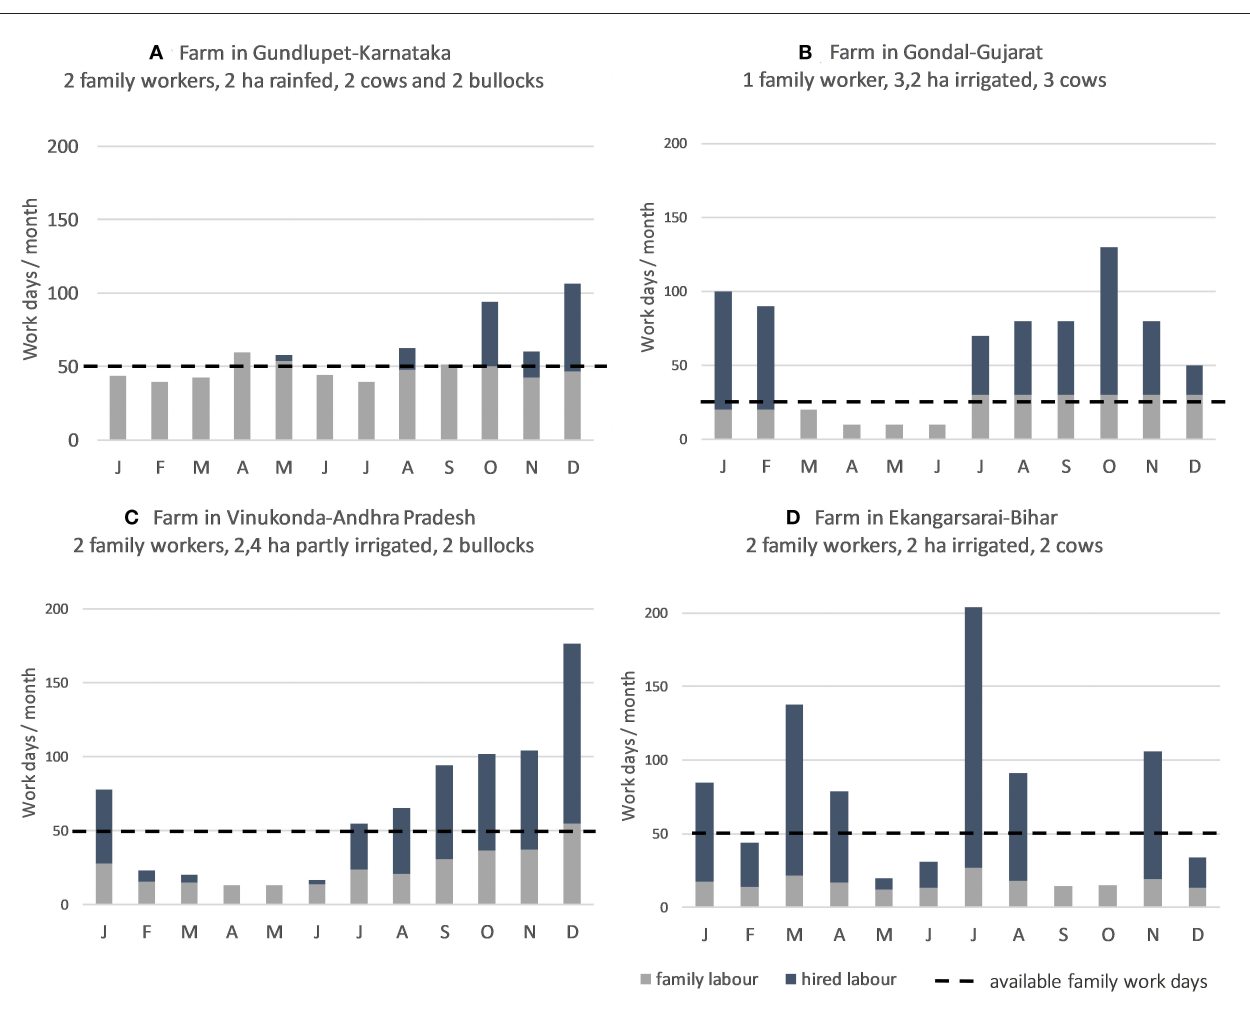
FIGURE 6 | Work calendar for four contrasting types of farm. Source: C. Aubron, S. Bainville and O. Philippon based on agrarian diagnoses IndiaMilk project (Rabassa and Lasina, 2015; Fischer, 2016; Furlan and Bonnard, 2016; Marblé,